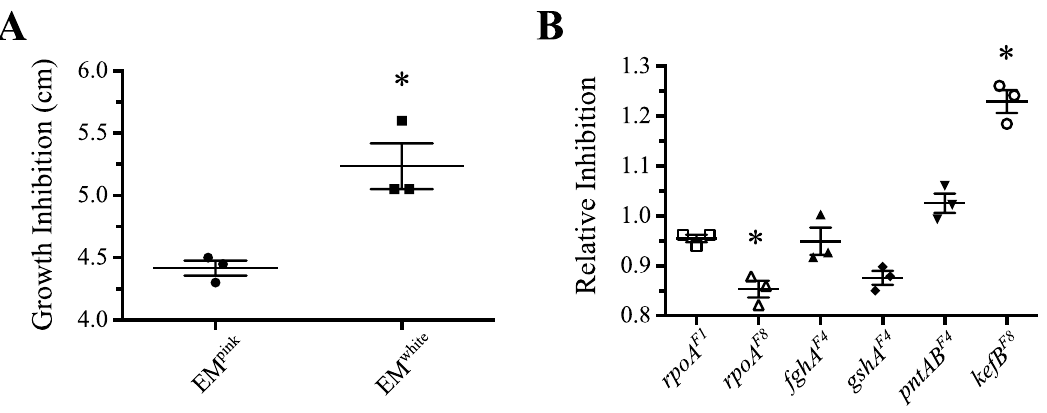
Figure 4. Stress test of rpoA and other mutants grown on methanol plates with hydrogen peroxide. ( A ) Interestingly, pink and white EM ancestors were not equivalent in these growth conditions, as the pink-pigmented strain with carotenoids was roughly 19% more resistant against hydrogen peroxide. ( B ) Upon normalizing the growth of mutants to their respective pink/white ancestor, several mutants—including rpoA EVO —offered protection against hydrogen peroxide. Asterisk (*) indicates p < 0.05 in a two-tailed, unpaired t test assuming unequal variance. Note that the gshA F4 allele imparted a marginally insignificant reduction in inhibition ( p =